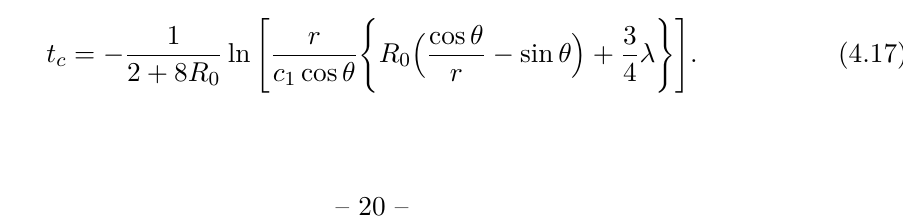
against r and θ in the domain r < r cos θ